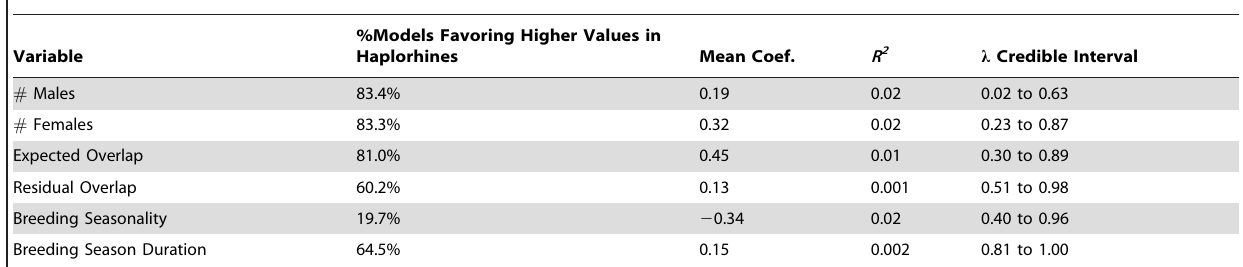
Table 2. Differences in strepsirrhines and